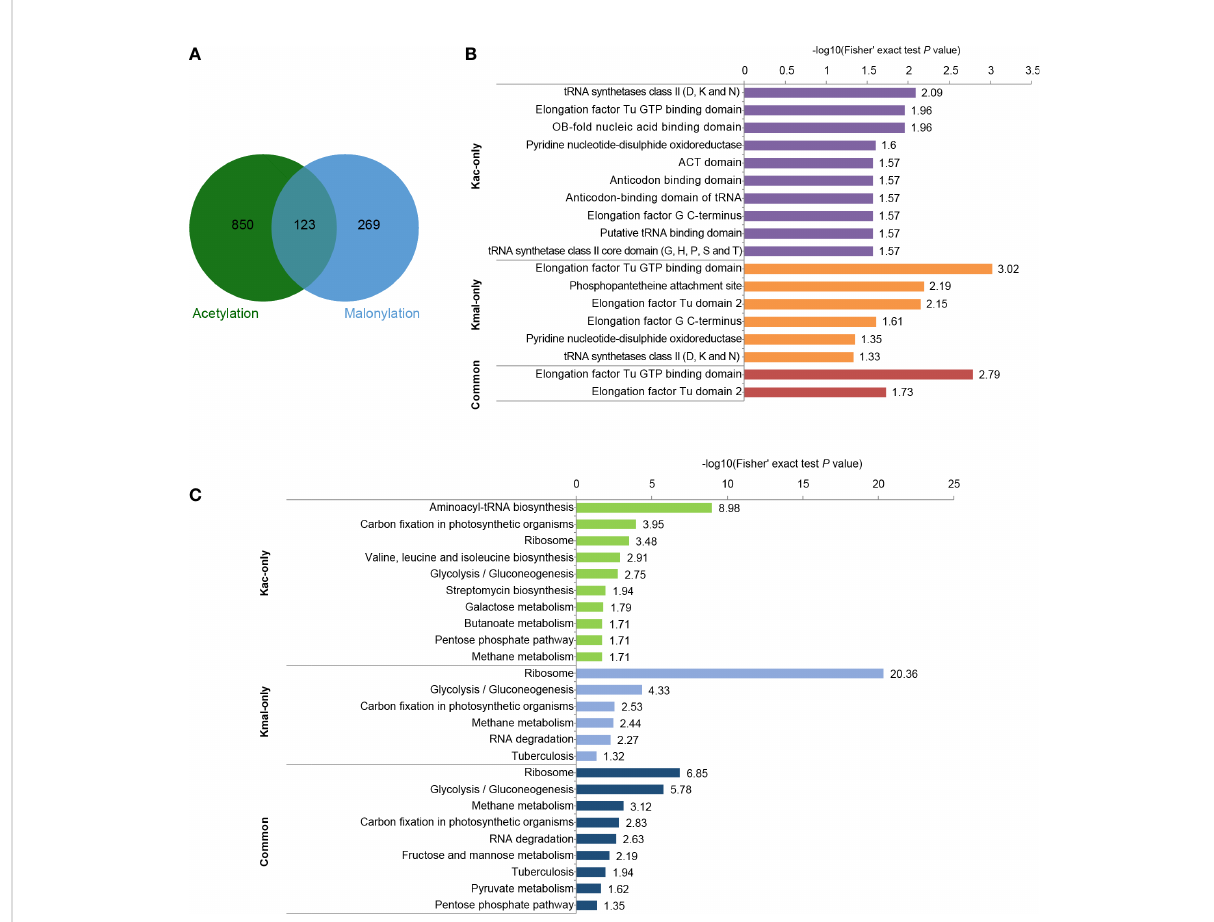
FIGURE 5 Comparison of acetylome and malonylome in S. mutans . (A) Venn diagram showing the total number of Kac-only, Kmal-only and overlapping sites. (B) Pfam-based domain enrichment for these common and unique sites of the two acylome datasets. (C) KEGG-based pathway enrichment for these common and unique sites of the two acylome datasets. For each category, a two-tailed Fisher ’ s exact test was employed to test the enrichment of the identi fi ed modi fi ed proteins against all proteins in the species database. Fold enrichment > 1.5 and adjusted P values < 0.05 were considered signi fi